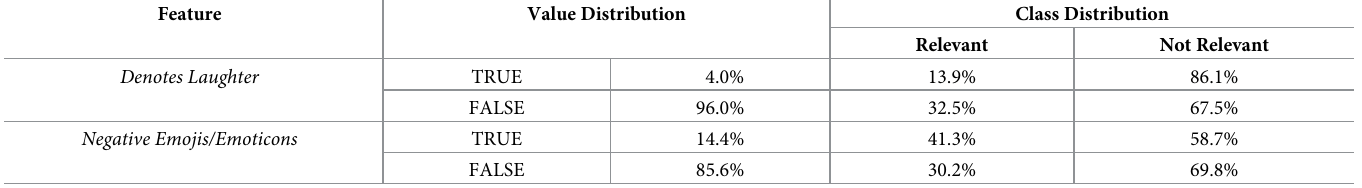
Table 6. Distribution of constructed features and classes across tweets from a different time period 2 years apart from our that of our investigated dataset.